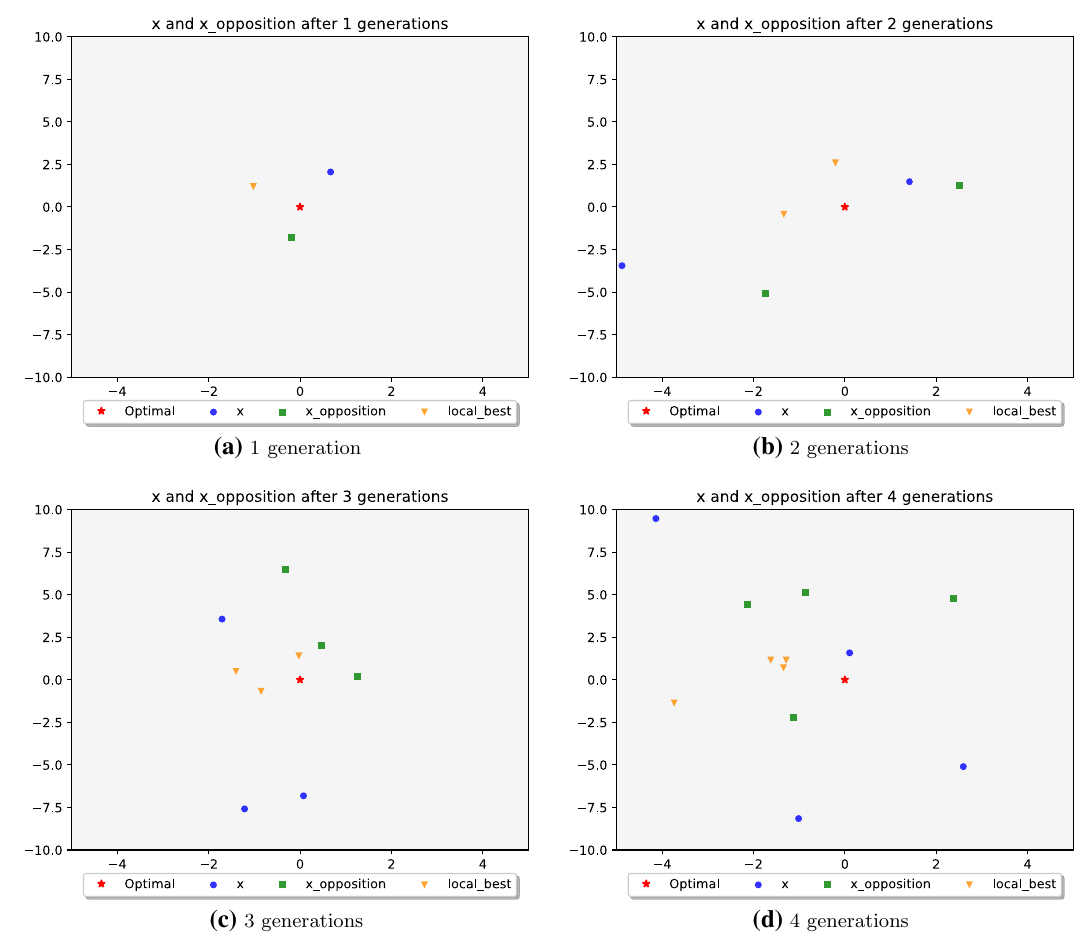
Fig. 1 Position visualization of X g + 1 and X g + 1 oppo after 1 ( a ), 2 ( b ), 3 ( c ), 4 ( d ) generations on 2-D